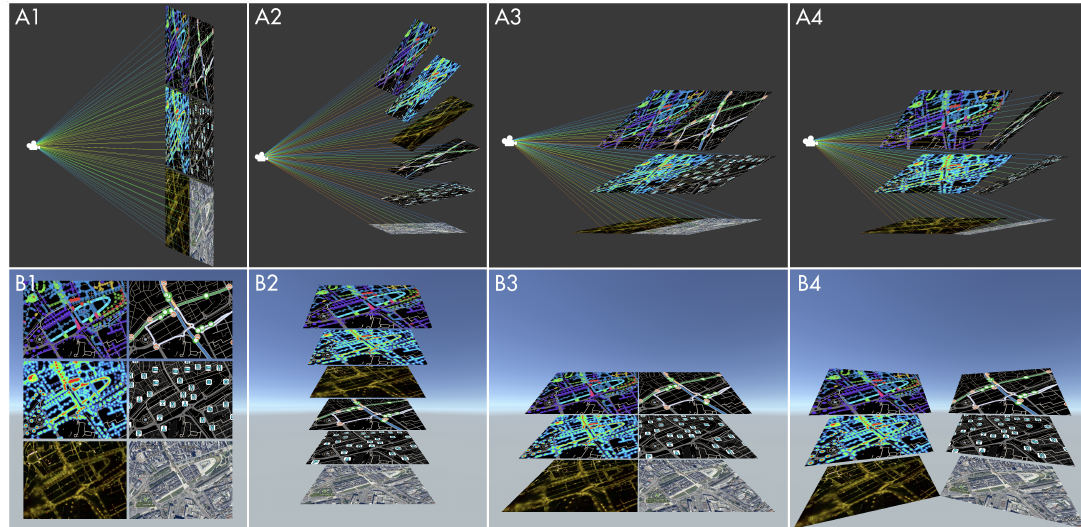
Figure A2. ( A )bove ( A1 – A4 ): Isometric views from the side of a flat configuration of six layers ( A1 ), one stack with each layer tilted at 25 degrees ( A2 ), two stacks with each layer tilted at 35 degrees ( A3 ), and two stacks as in ( A3 ) but rotated to face the viewer ( A4 ). Colored lines illustrate distances as in Figure A1. ( B )elow ( B1 – B4 ): the corresponding camera views of the same number in ( A ), with equal fields of view (cropped sides in ( B1 , B2 )). All layers equal in